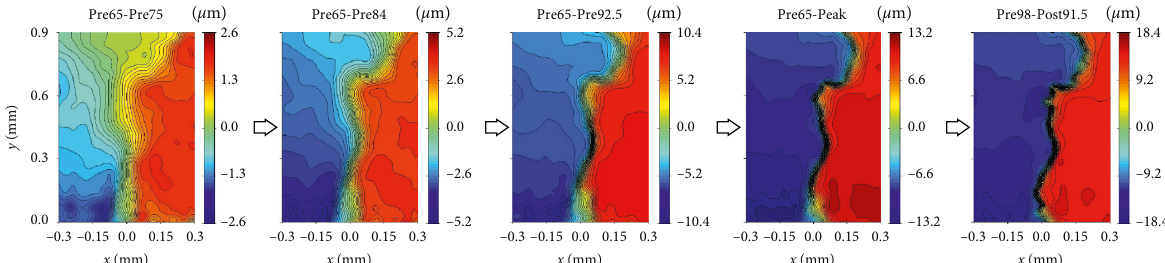
Figure 11: Distributions of horizontal incremental displacement at notch tip for specimen TPB-3.0-1 with the range of 0.6mm based on the DIC calculation obtained from the microscopic images under different loading levels.